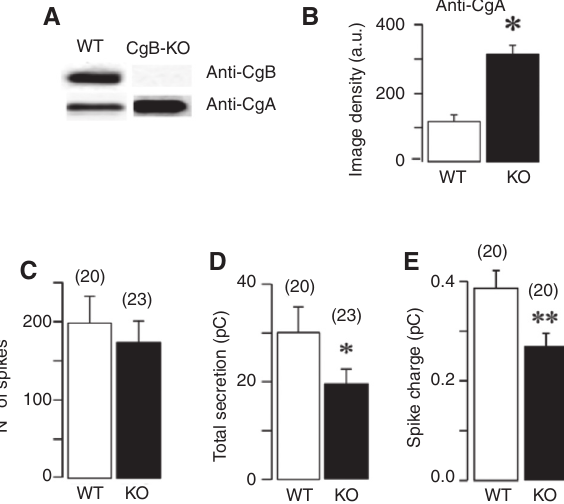
Figure 3 Secretory characteristics of the CgB-KO mouse. (A) Western blot showing the absence of CgB and the overexpres- sion of CgA. (B) Quantification of CgA expression in WT and CgB-KO animals from three different experiments, the densitometry analysis is expressed in arbitrary units. (C) Temporal distribution of secretory spikes over a 2-min recording. (D) Cumulative secretion obtained as described in the legend to Figure 1. (E) The net spike charge (Q, expressed in pCoulombs) from WT and KO